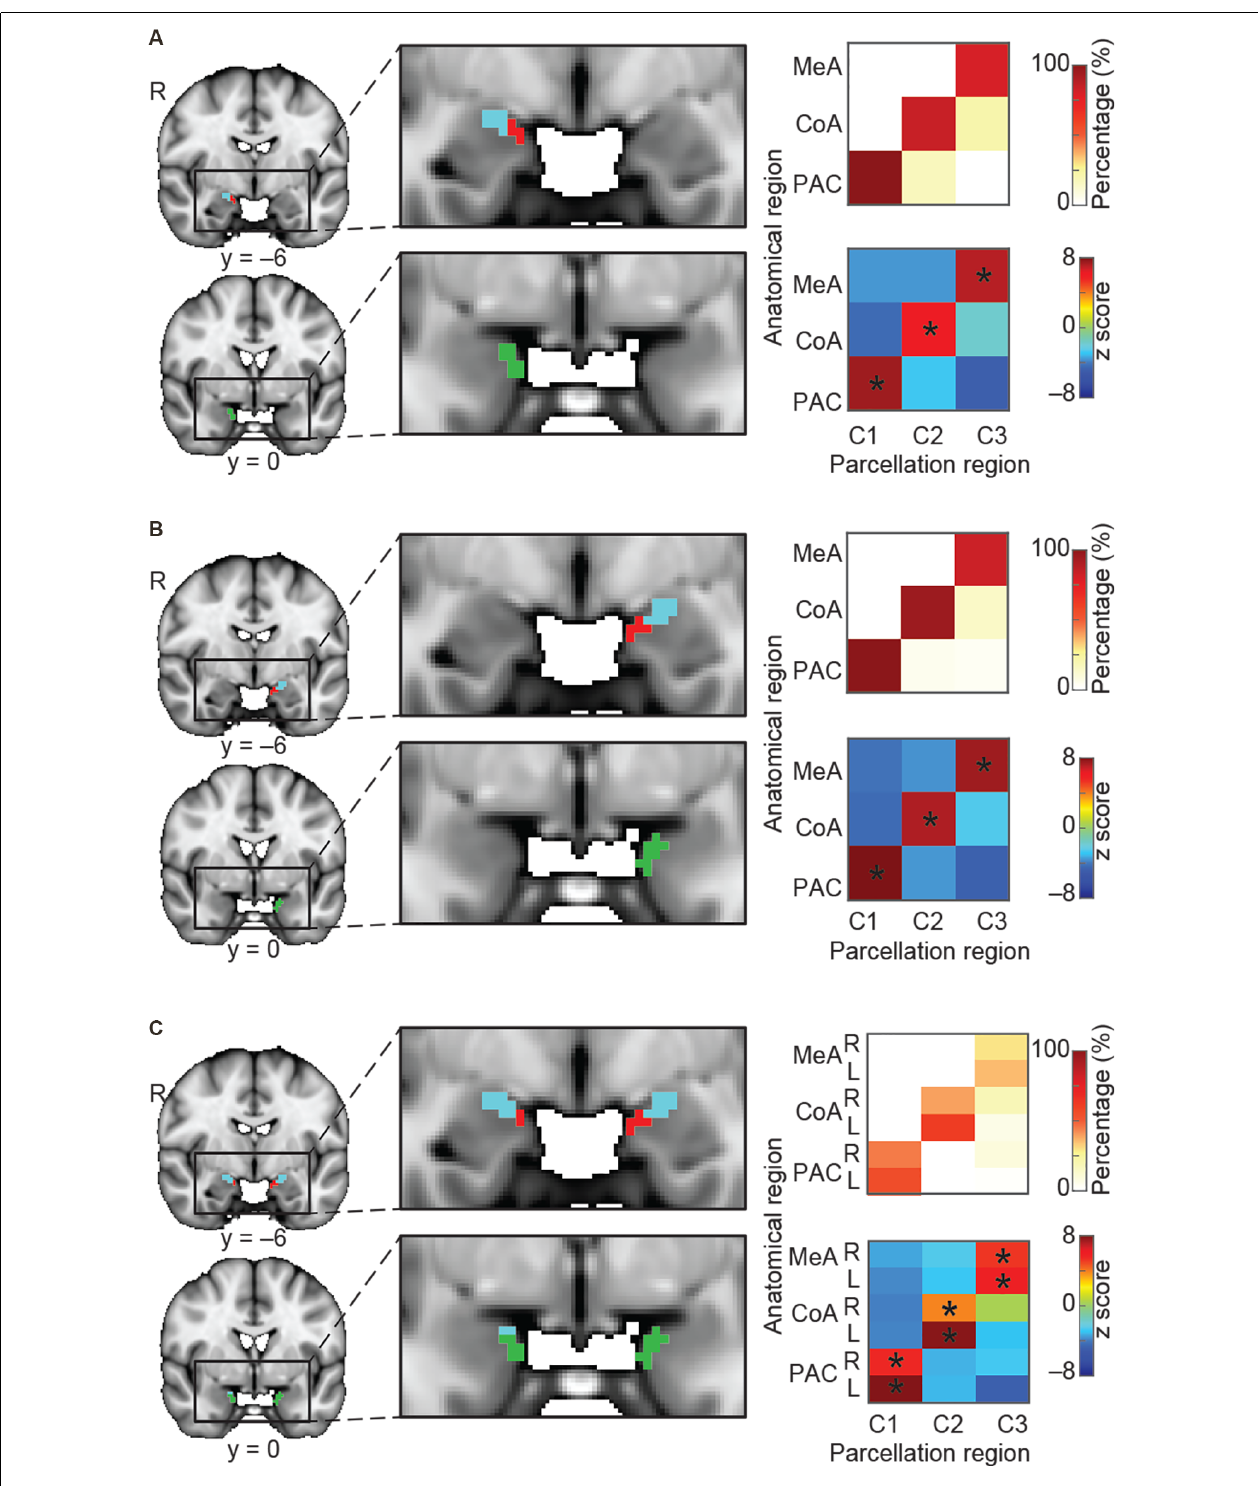
FIGURE 3 | Parcellation of the olfactory amygdala subregions based on resting state connectivity. K-means ( k = 3) clustering analysis was performed for the right hemisphere (A) , left hemisphere (B) , and combined left and right (C) hemispheres. Each color (red, blue, and green) in (A–C) indicates one cluster. Results are shown on the FSL’s MNI152_T1_1 mm_brain. Parcellation accuracy of each subregion is shown on the right. Top right: proportion of voxels from each parcellation subdivision located within each anatomical subregion. Bottom right: z score of the proportion maps. *Indicates P < 0.05 (Bonferroni corrected). L, left hemisphere; R, right hemisphere; MeA, medial amygdala; CoA, cortical amygdala; PAC, periamygdaloid complex.